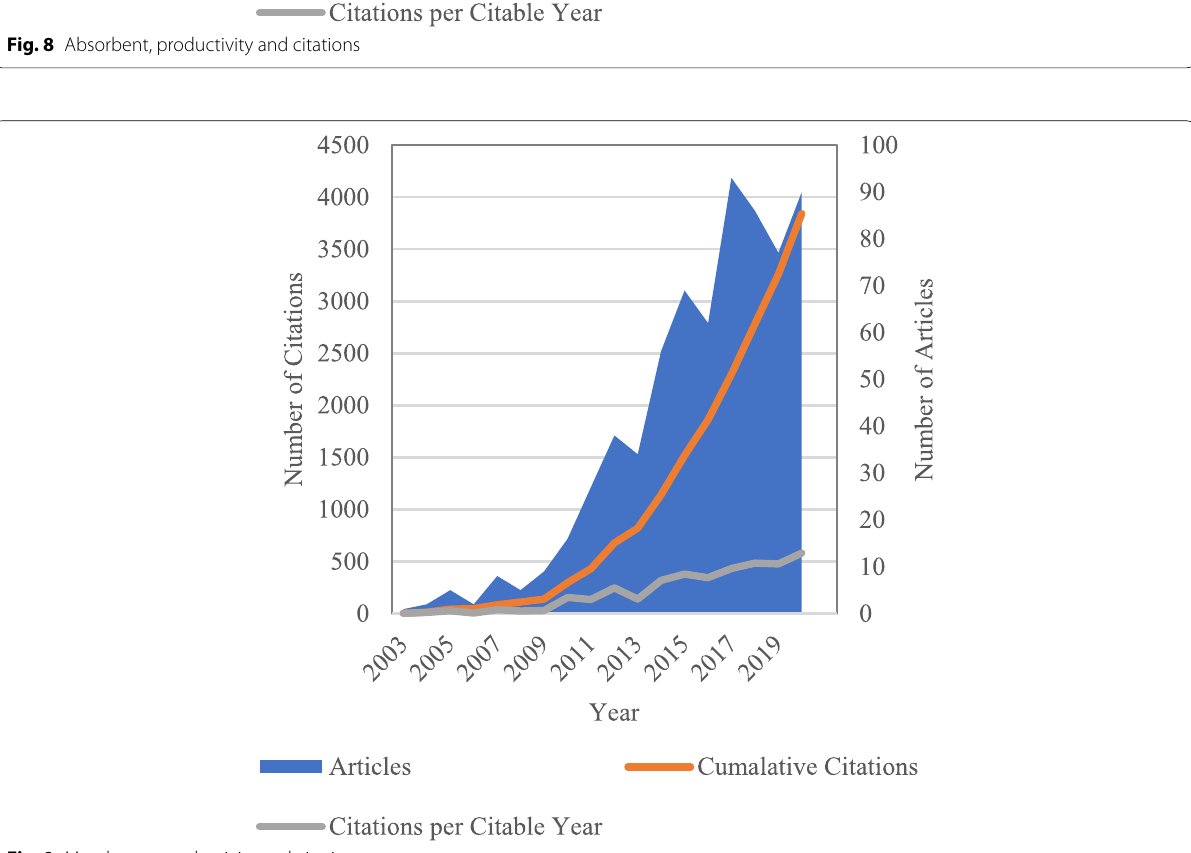
Fig. 9 Membrane, productivity and